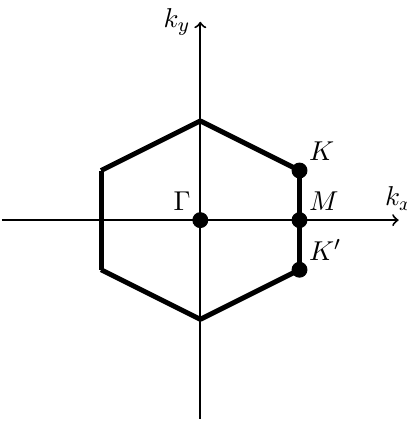
Figure 2 . Graphene honeycomb lattice in k space. The Dirac cones are located at the K and K 0 points, and we call them Dirac